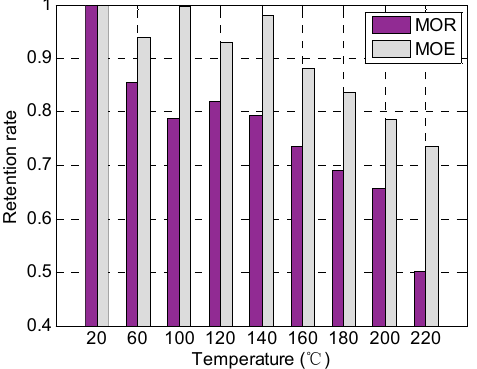
Figure 12. MOR and MOE degradation at elevated temperatures.